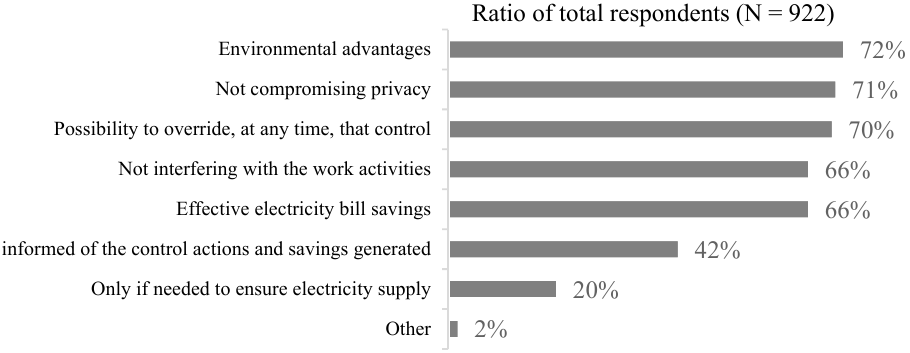
Figure 7. Conditions to follow the recommendations from the electricity utility and manually control the appliances.